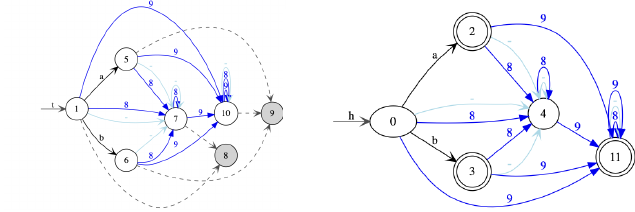
Figure 15. The determinized SHA det ( step ( ch ∗ ( a + b )))